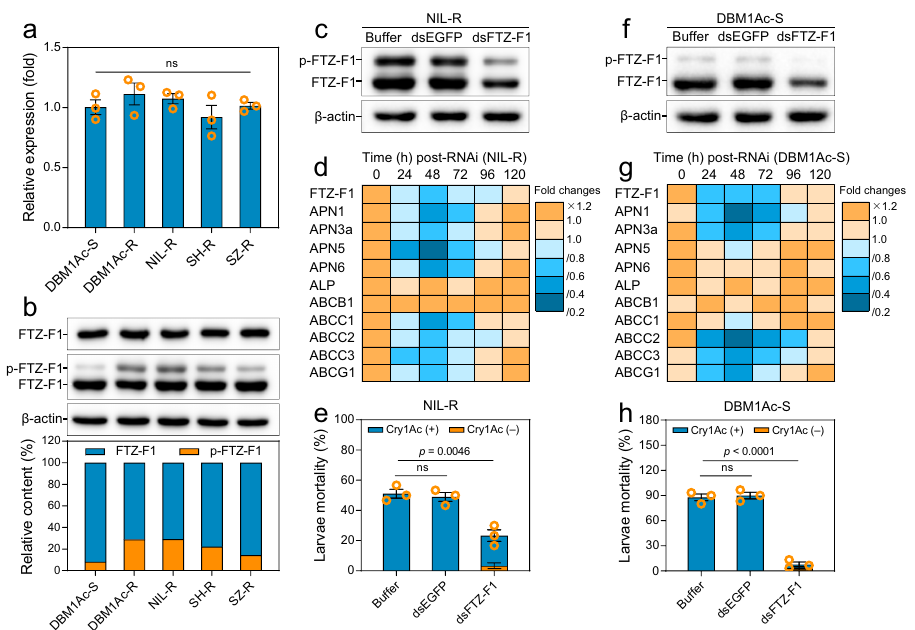
Fig. 5 | Elevated phosphorylation of FTZ-F1 in vivo enhances resistance of P. xylostella larvaetoCry1Actoxin.a FTZ-F1 transcriptlevelinthelarvalmidgutofa susceptible DBM1Ac-S strain and four resistant P. xylostella strains. The relative expression level was quantitated and normalized to the expression level of the RPL32 gene and the value in the DBM1Ac-S strain wasset as1. b Protein expression and phosphorylation levels of FTZ-F1 in the larval midgut of the same fi ve P. xylostella strains. Phosphorylated and non-phosphorylated FTZ-F1 proteins were separatedonaPhos-tagSDS-PAGEgel,detectedbyanti-FTZ-F1,andquantitatedby densitometry using the ImageJ 1.51 software and normalized to the β -actin.